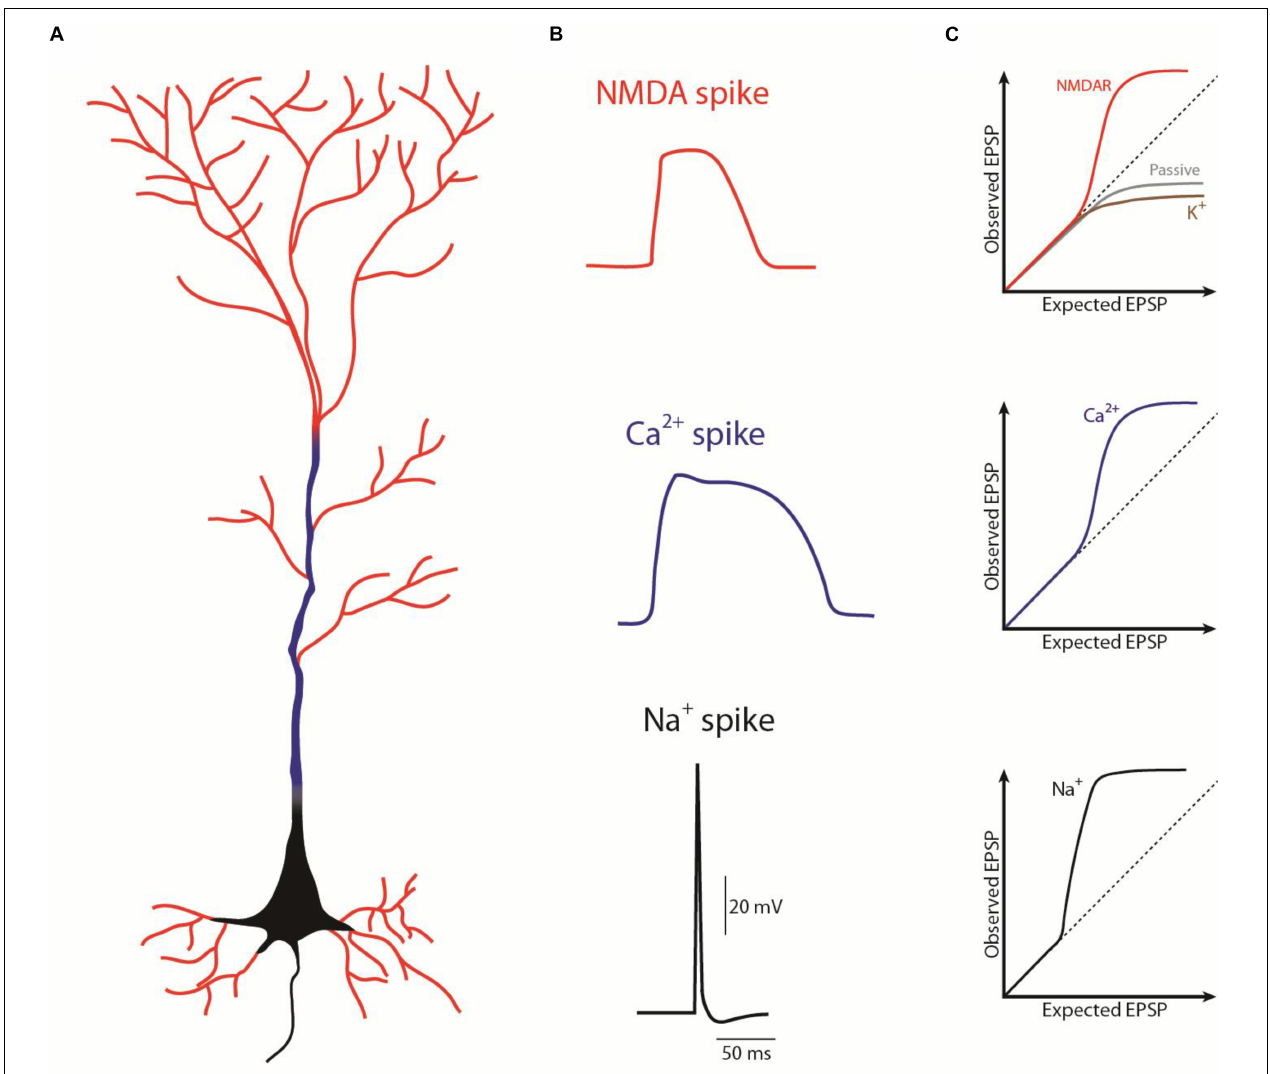
FIGURE 1 | Schematic representation of the different spikes in a pyramidal neuron. (A) Representation of where the different spikes take place: NMDA spikes (red) in “thin” dendrites, Ca 2 + spikes (blue) in “thick” dendrites, Na + spikes or action potential (black) in the axon (as in Larkum et al., 2009). (B) Waveform of the different spike (as in Antic et al., 2010). (C) Contribution of the different ion channels on the excitatory postsynaptic potentials (EPSP) summation; supralinear summation above the dashed line, sublinear summation bellow the dashed line. EPSP summation properties depends not only on the ion channels but on the combination between those, morphology (dendritic diameter, distance from soma, and branchpoints) and synaptic strength. A combination of those can give rise, for example to a linear summation (as in Tran-Van-Minh et al., 2015).